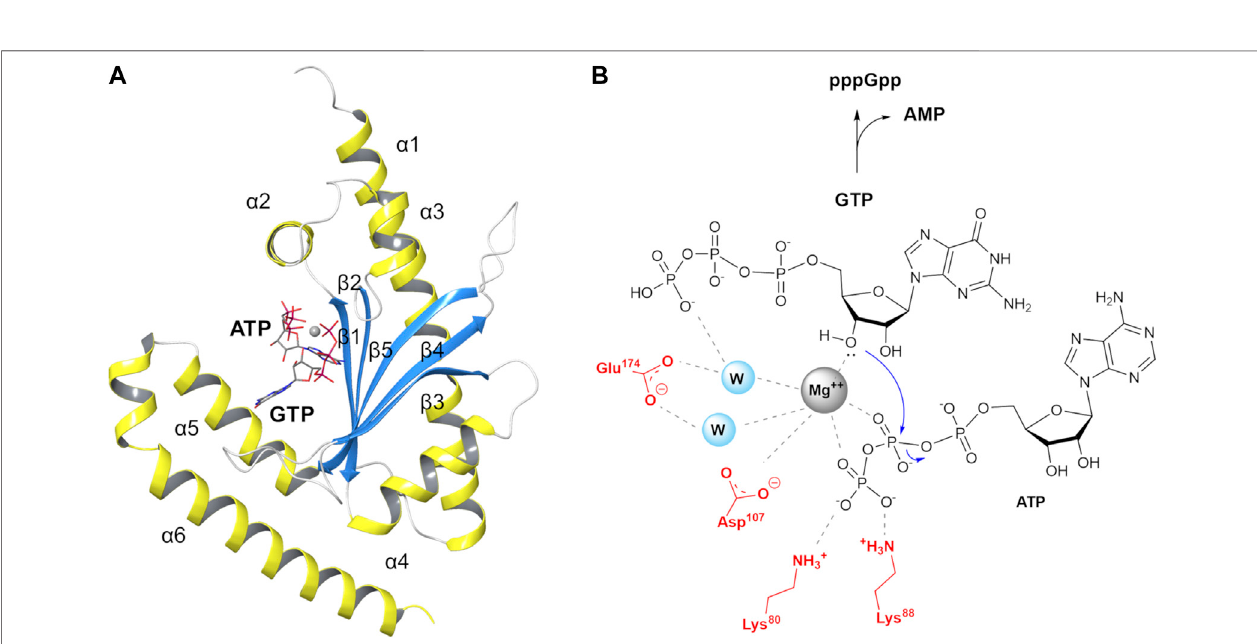
FIGURE2| S.aureus RelP smallalarmonesynthetase andits postulated reaction mechanism (A) RelPpre-catalytic state(6EWZ.pdb)incomplexwithGTP,AMP- CPP and Mg 2+ (gray sphere). (B) Proposed reaction mechanism for pppGpp synthesis.